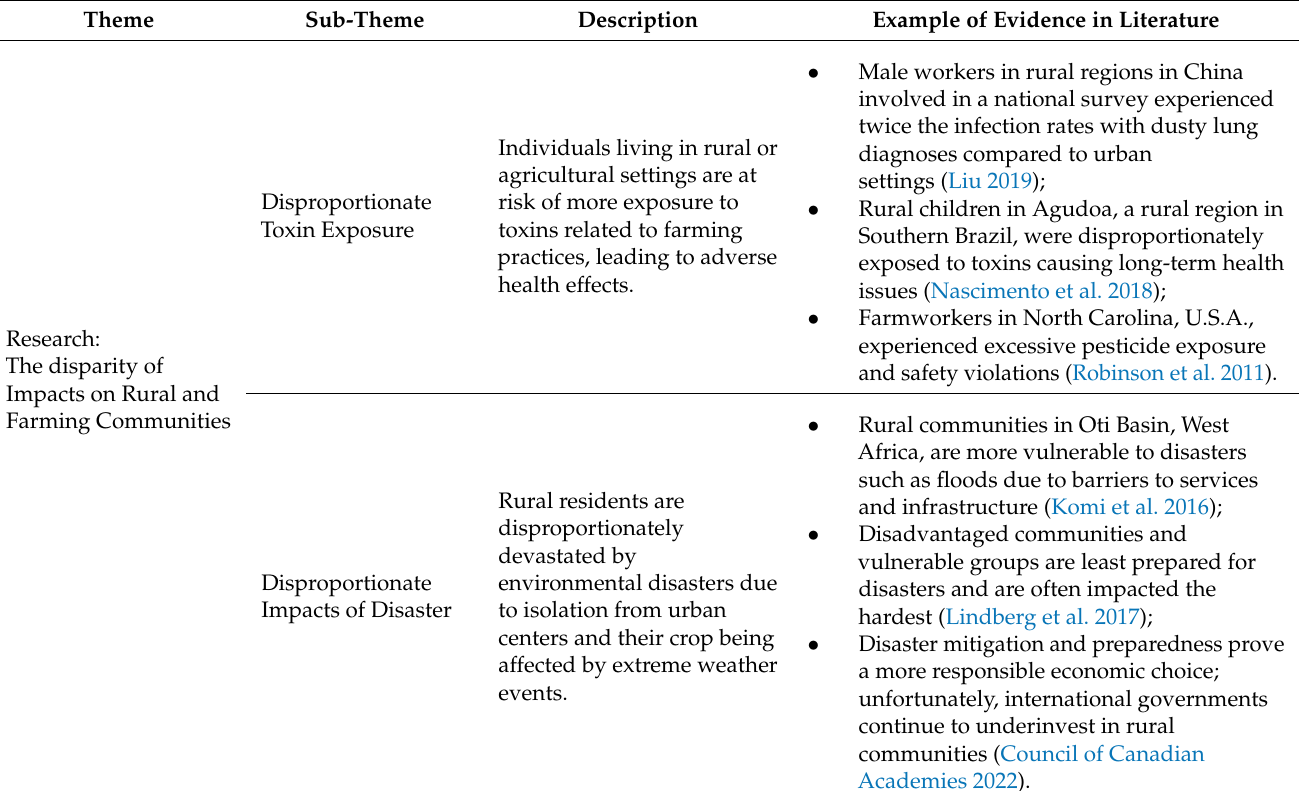
Table 1. General Theme and